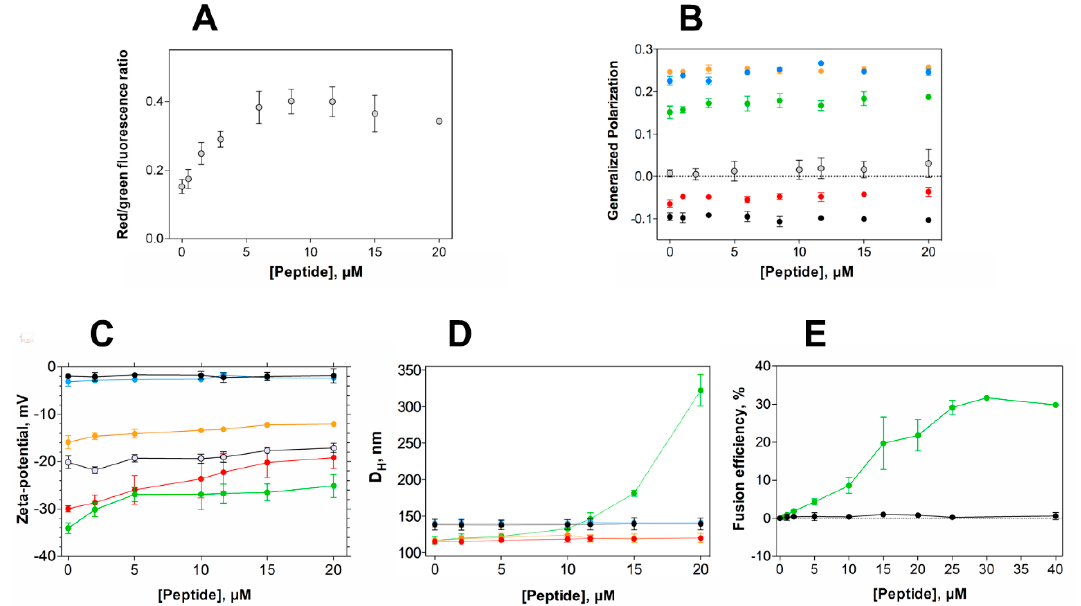
Figure 4. Alterations in membrane properties induced by EcDBS1R4. ( A ) Effect of EcDBS1R4 on the transmembrane potential of E. coli cells, calculated from the DiOC 2 (3) green shift. ( B ) Generalized polarization of LUVs (3 mM lipid) and E. coli cells (1 × 10 4 cells/mL) labelled with Laurdan, as a function of peptide concentration. ( C ) Zeta-potential of LUVs (200 µM lipid) and E. coli cells as a function of peptide concentration. ( D ) Hydrodynamic diameter of LUVs (200 µM lipid), measured by dynamic light scattering as a function of EcDBS1R4 concentration. ( E ) Fusion/hemifusion efficiency of IML (PE:PG:CL (63:33:4)) LUVs (200 µM lipid) as a function of peptide concentration, calculated using Equation (8). The LUV compositions used were POPC (black), POPC:Chol 70:30 (blue), POPC:POPG 70:30 (red), IML (POPE:POPG:CL 63:33:4) (green) and OML (POPE:POPG:CL:LPS 80:16:1:3) (orange). E. coli cells are represented by grey open circles. All experiments were conducted in triplicate. Data are presented as mean ± SD.